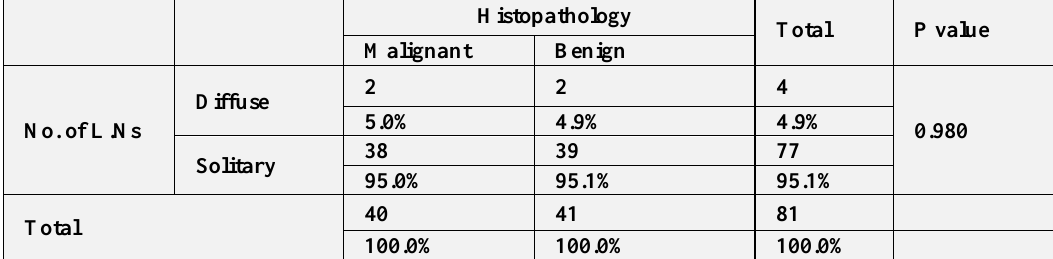
Table (9) :-Association between number of L.Ns and histopathological findings.